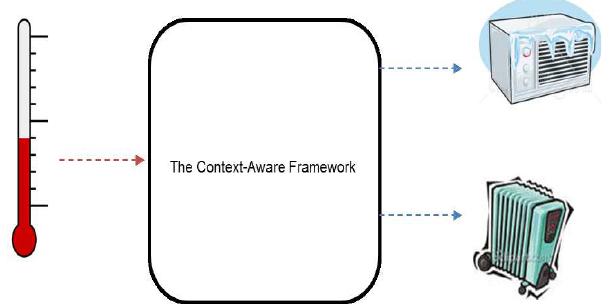
Figure 6. Temperature Control System